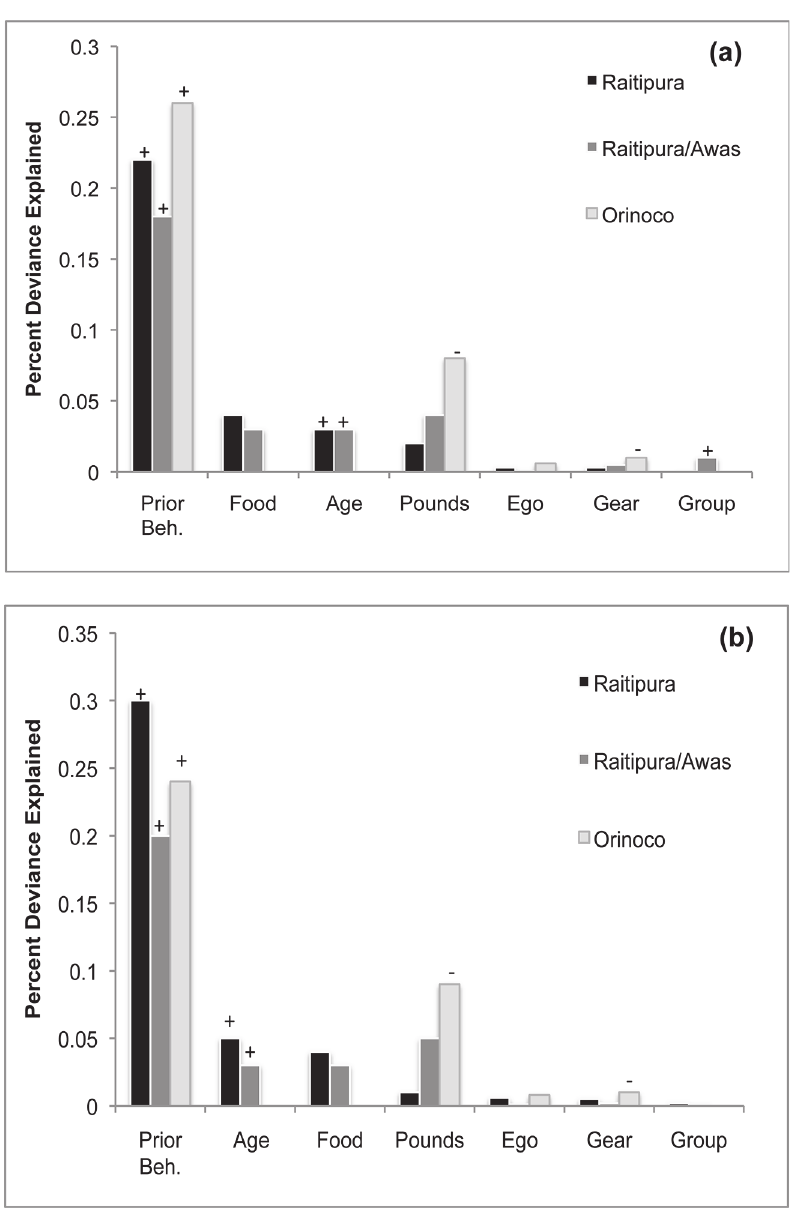
Fig 2. Percent deviance of each parameter. Percent deviance explained by each parameter in the best-fit model explaining fishermen ’ s enforcement behavior for the (a) friends network and the (b) fishing partners network. If the parameter estimate plus/minus the standard error does not include zero, the direction of the parameter estimate is indicated above the